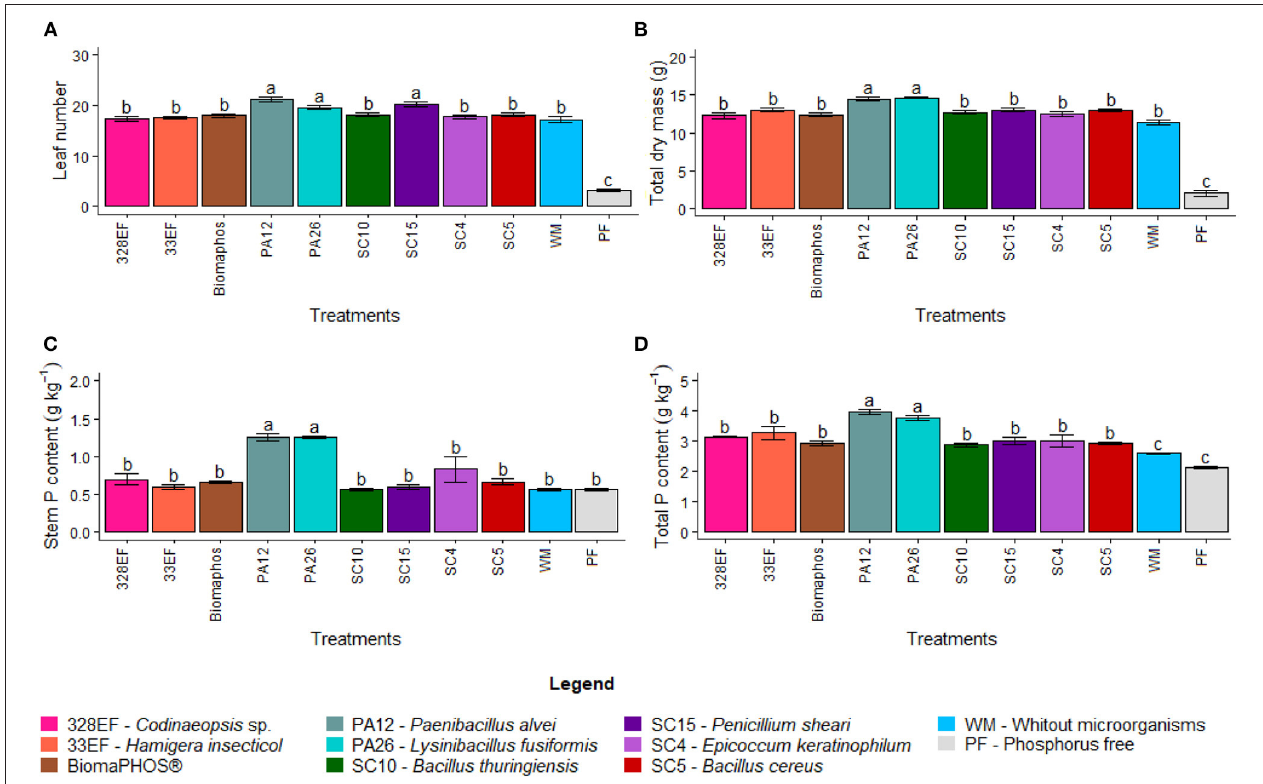
FIGURE 2 | Number of leaves (A) , total dry mass (B) , P tissue content in the stem (C) , and total P tissue content (D) in soybean plants ( Glycine max) grown in nutrient solution providing calcium phosphate (CaHPO 4 ) as the phosphate source and inoculated with four bacterial strains and four fungal strains. Means followed by the same lowercase letter do not differ from one another according to the Scott-Knott test at 5% probability.